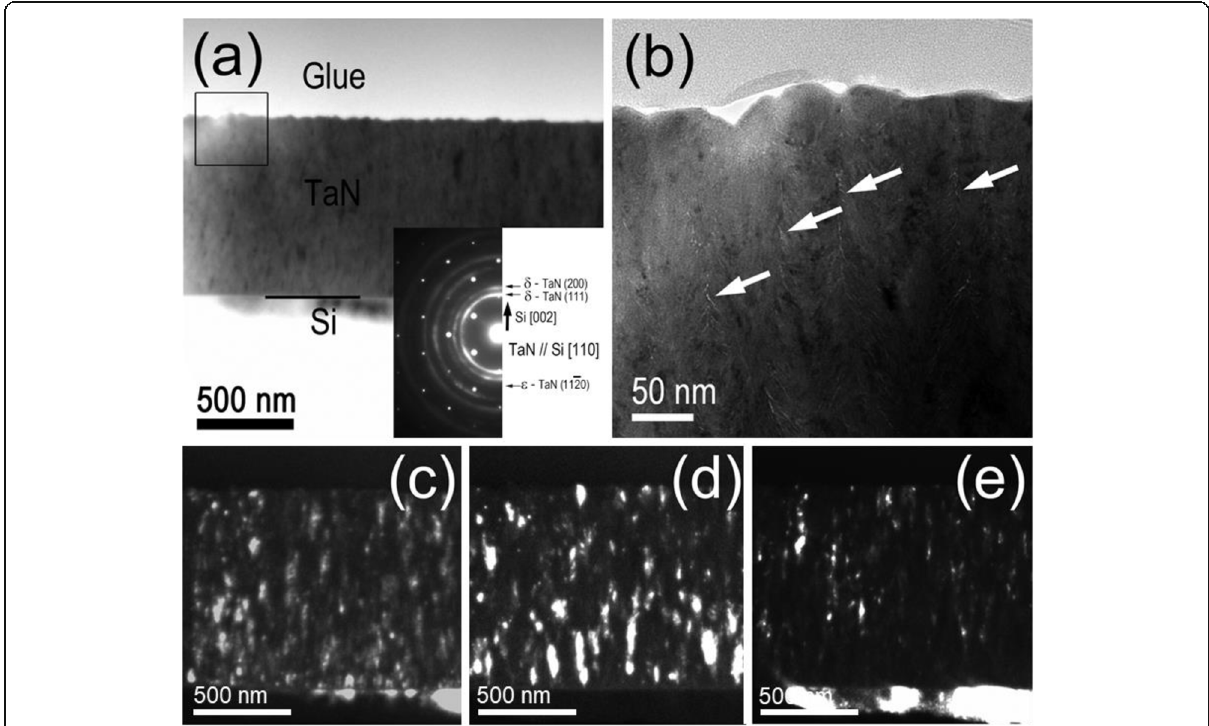
Fig. 6 Cross-sectional ( X) TEM analysis of TaN x film grown with 0.15 f N2 for 100 W ICP power. (a) BF TEM image with corresponding SADP in the